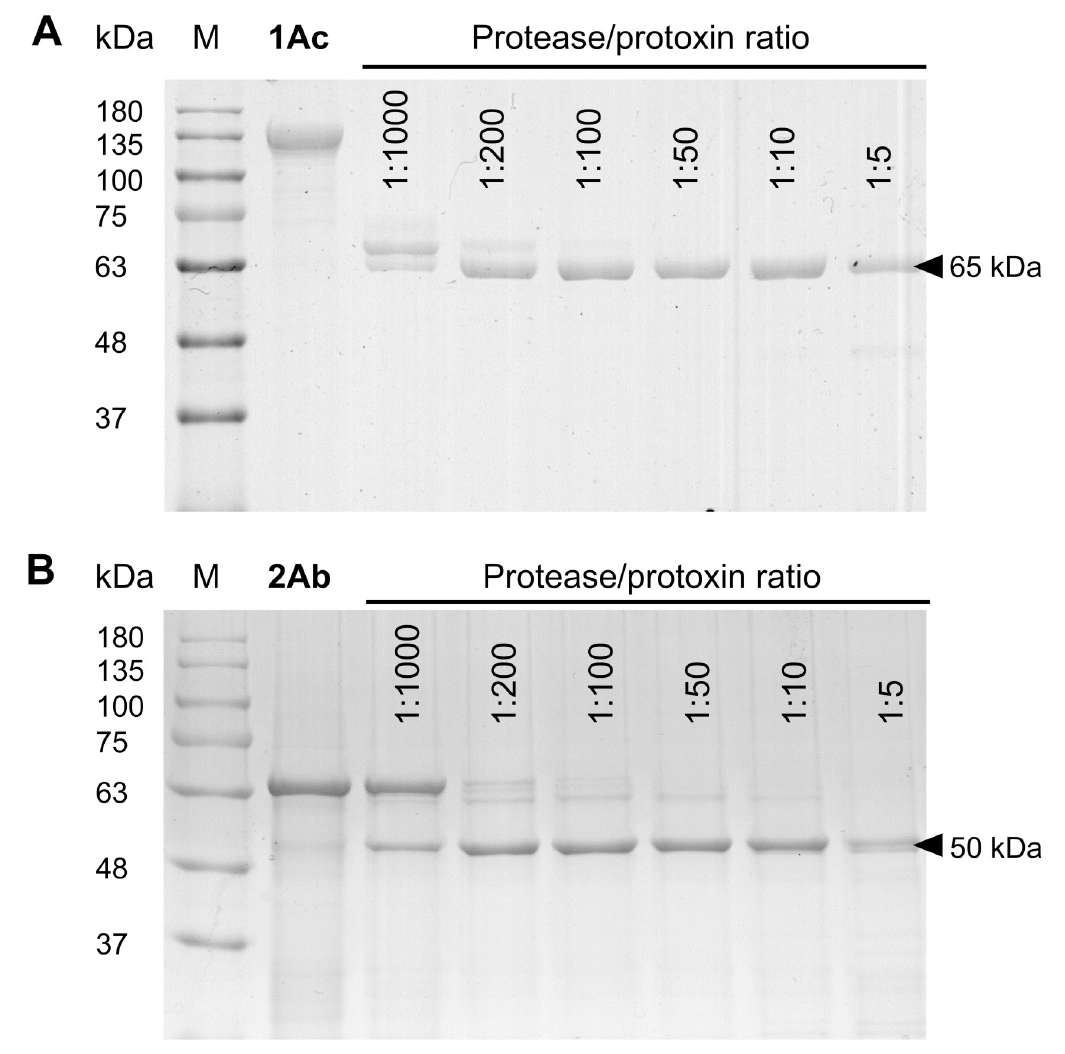
Fig 1. SDS-PAGE analysis proteolytic digestion of protoxins by H . armigera larval midgut juice. (A) The digestion of Cry1Ac protoxin. (B) The digestion of Cry2Ab protoxin. M, the BlueRay prestained protein marker (MDBio, Qingdao, China). Both protoxins were incubated with midgut juice at different midgut juice protein/protoxin ratios (total protein content of the gut juice added/5 μ g protoxin protein) for 1 h at 37˚C.